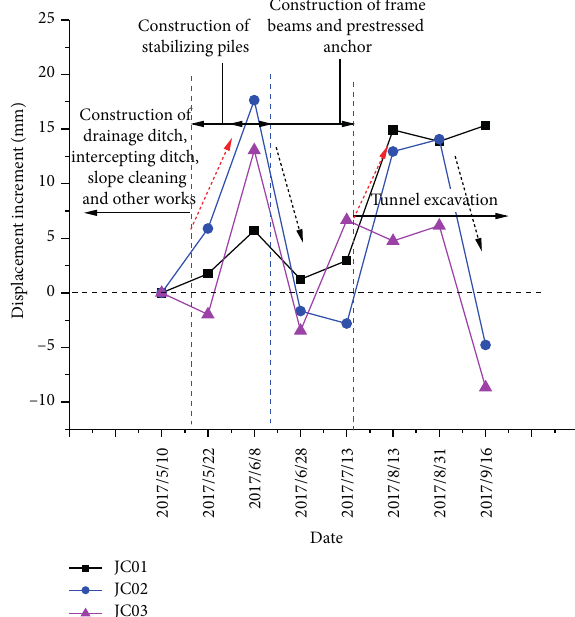
Figure 11: Field-monitored displacement increment data for the monitoring holes during slope reinforcement and tunnel